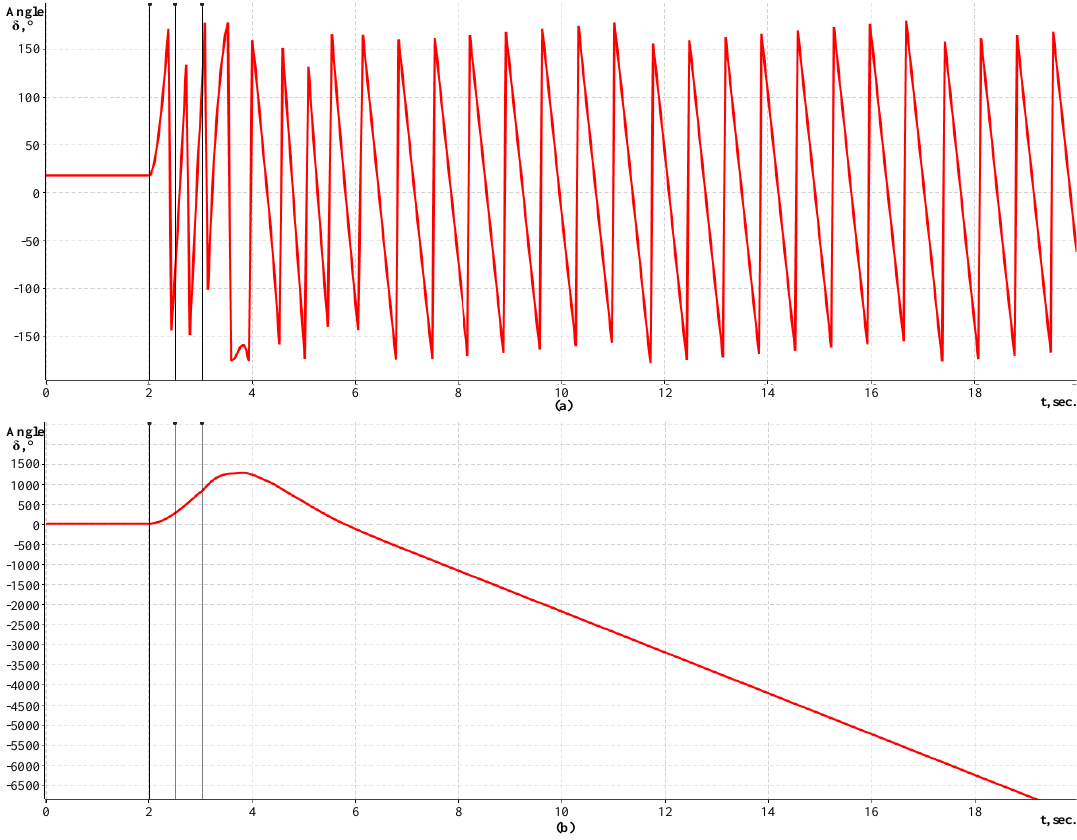
Energies 2020 , 13 , x FOR PEER REVIEW 15 of 19 Figure 7. The angle-time curve in case of disturbance: ( a ) ±180° curve; ( b ) incremental angle curve. Figure 7. The angle-time curve in case of disturbance: ( a ) ± 180 ◦ curve; ( b ) incremental angle curve.